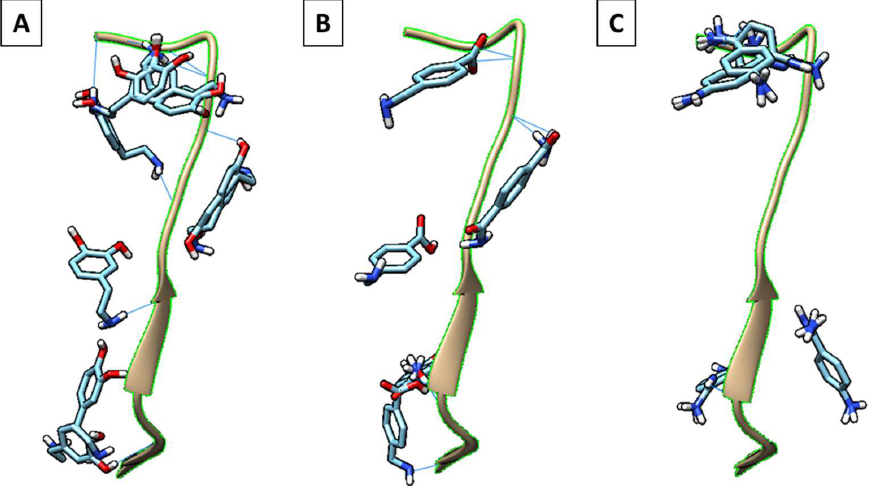
Figure 1. Binding poses of the ligands ( A ) 4−(aminomethyl)benzoic acid (MABA), ( B ) p−aminobenzamidine (PAB), and ( C ) dopamine clustered on the peptide that is in the center (highlighted with green). H−bonds are represented with solid lines. The monomer binding poses in each case were distributed in the binding energy range from −3.2 to −3.4 kcal/mol.